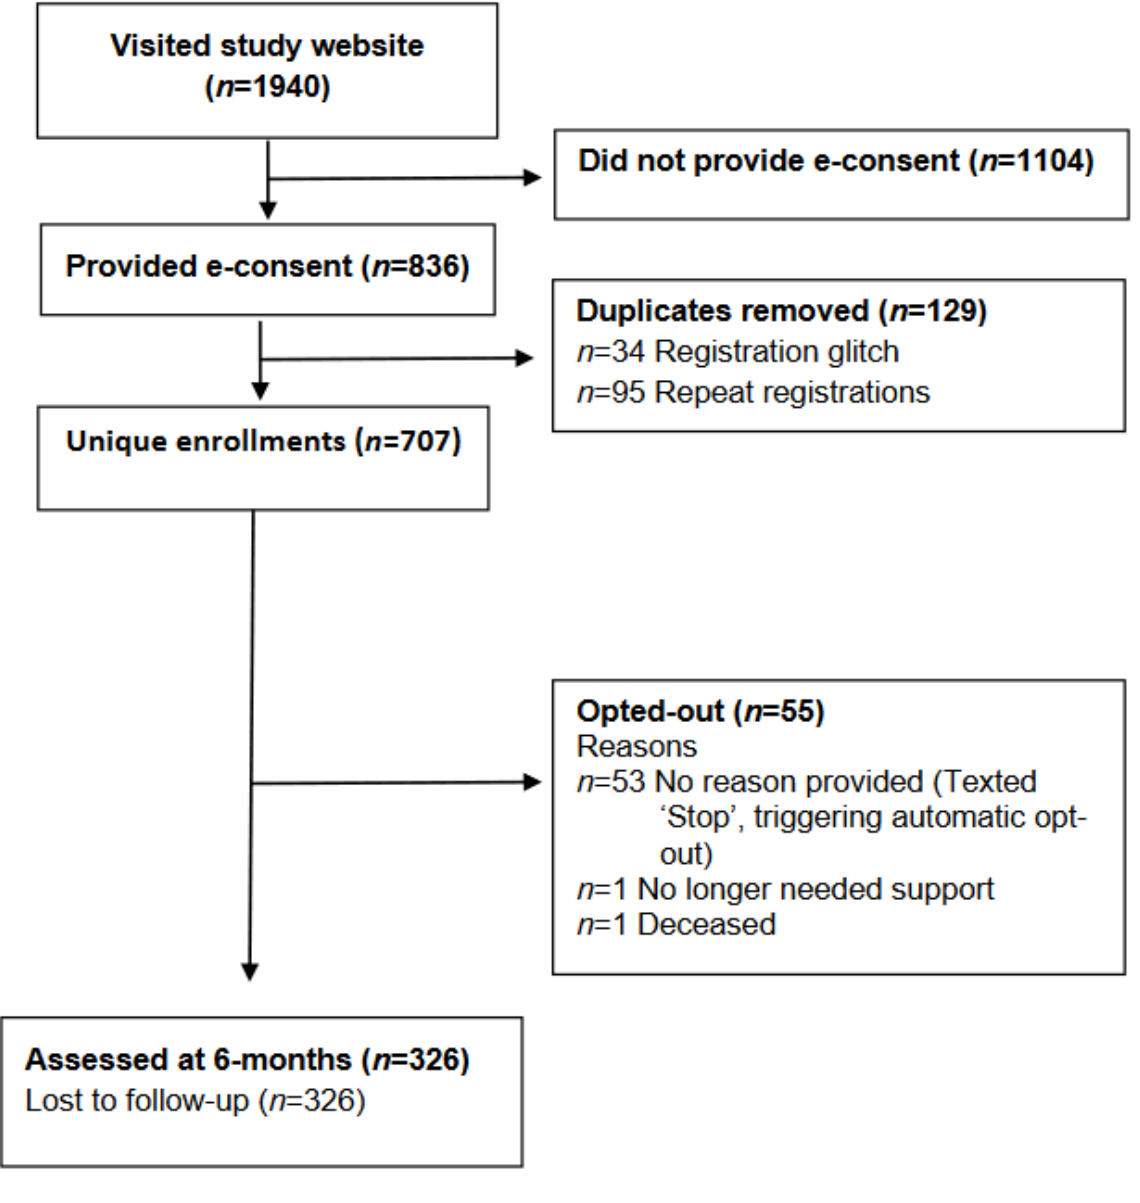
Figure 1. Study flow Figure 1 . Study flow diagram.